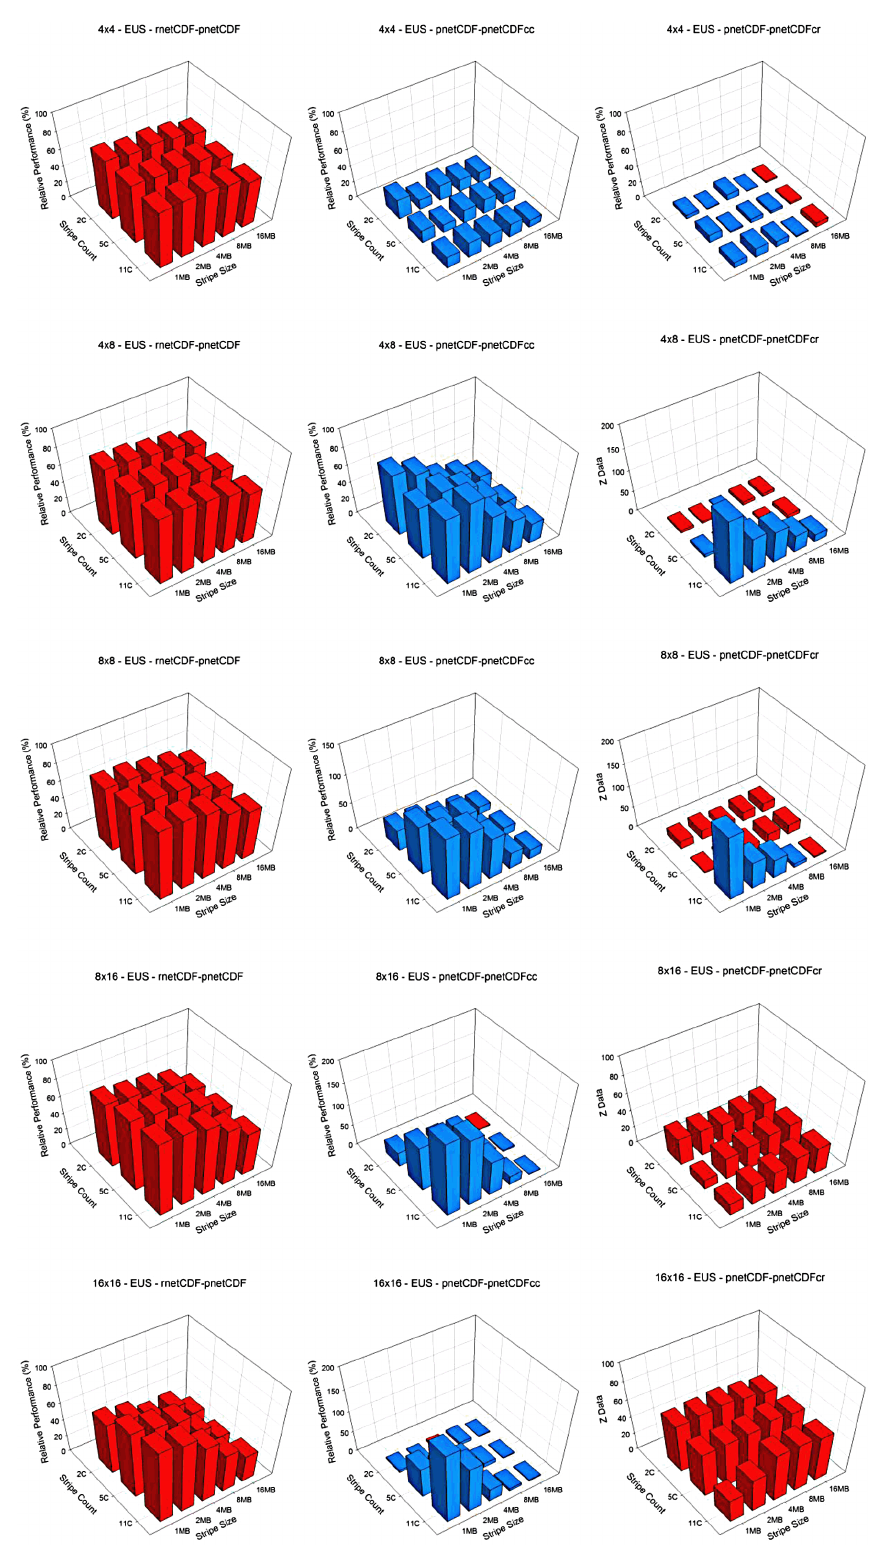
Figure 6. Relative I/O performance of pnetCDF to rnetCDF, and pnetCDFcc and pnetCDFcr to pnetCDF on the EUS domain with 4 × 4, 4 × 8, 8 × 8, 8 × 16, and 16 × 16 processor configurations from Edison. Red color denotes positive value in relative performance while blue color denotes negative value in relative